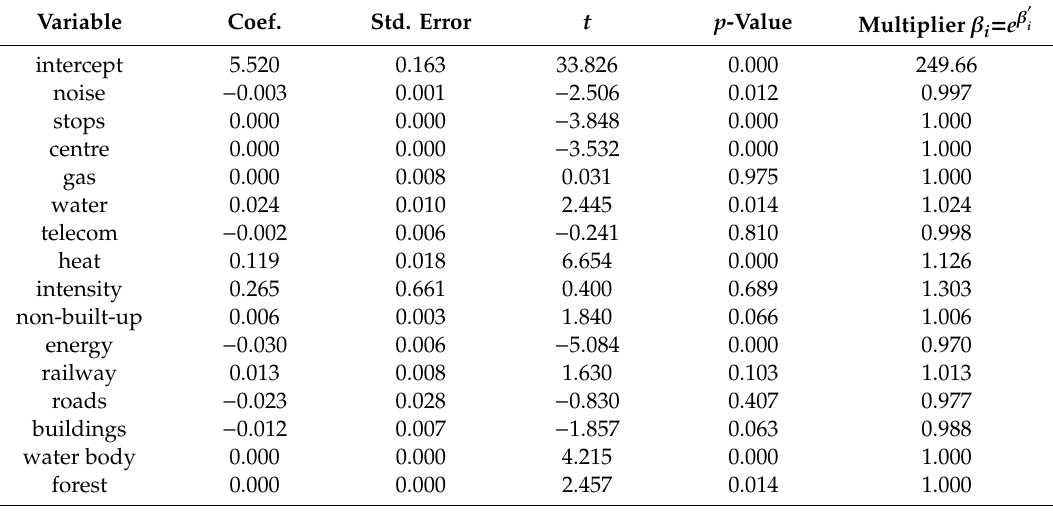
Table 7. Basic statistics of the spatial error